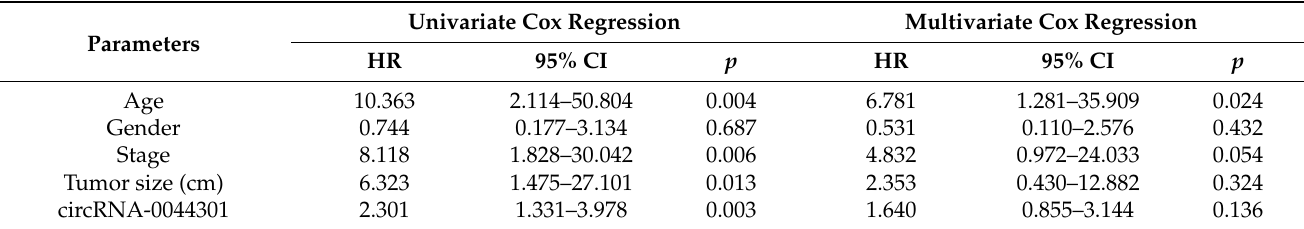
Table 2. Independent prognosis analysis of clinicopathological parameters and circRNA-0044301.